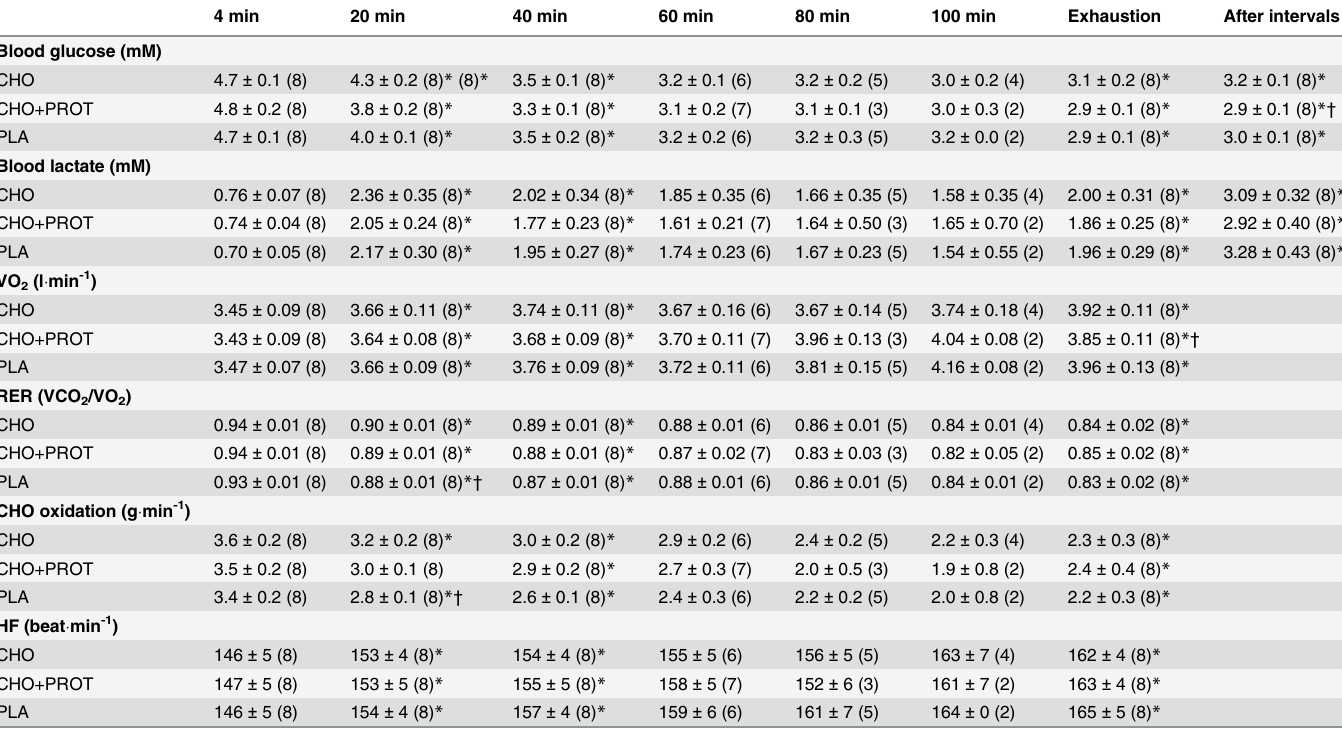
Table 1. Metabolic data during exhaustive exercise prior to the three diet interventions. Day 1.